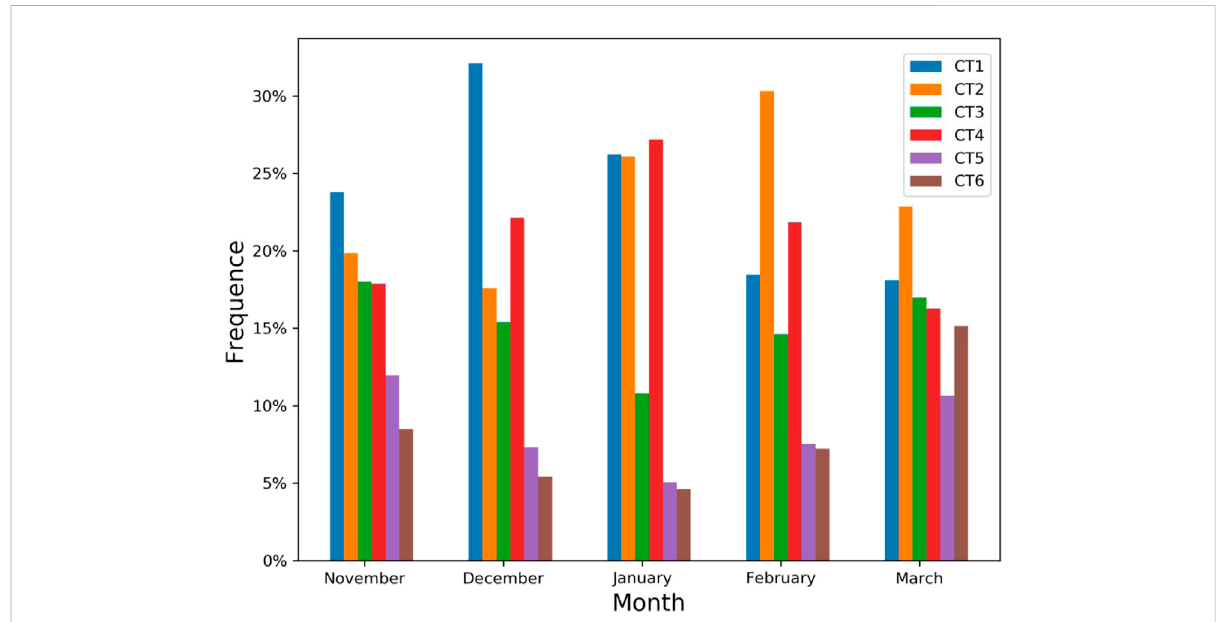
FIGURE 2 The monthly proportion of six circulation patterns in Beijing during the polluted period from 2000 to